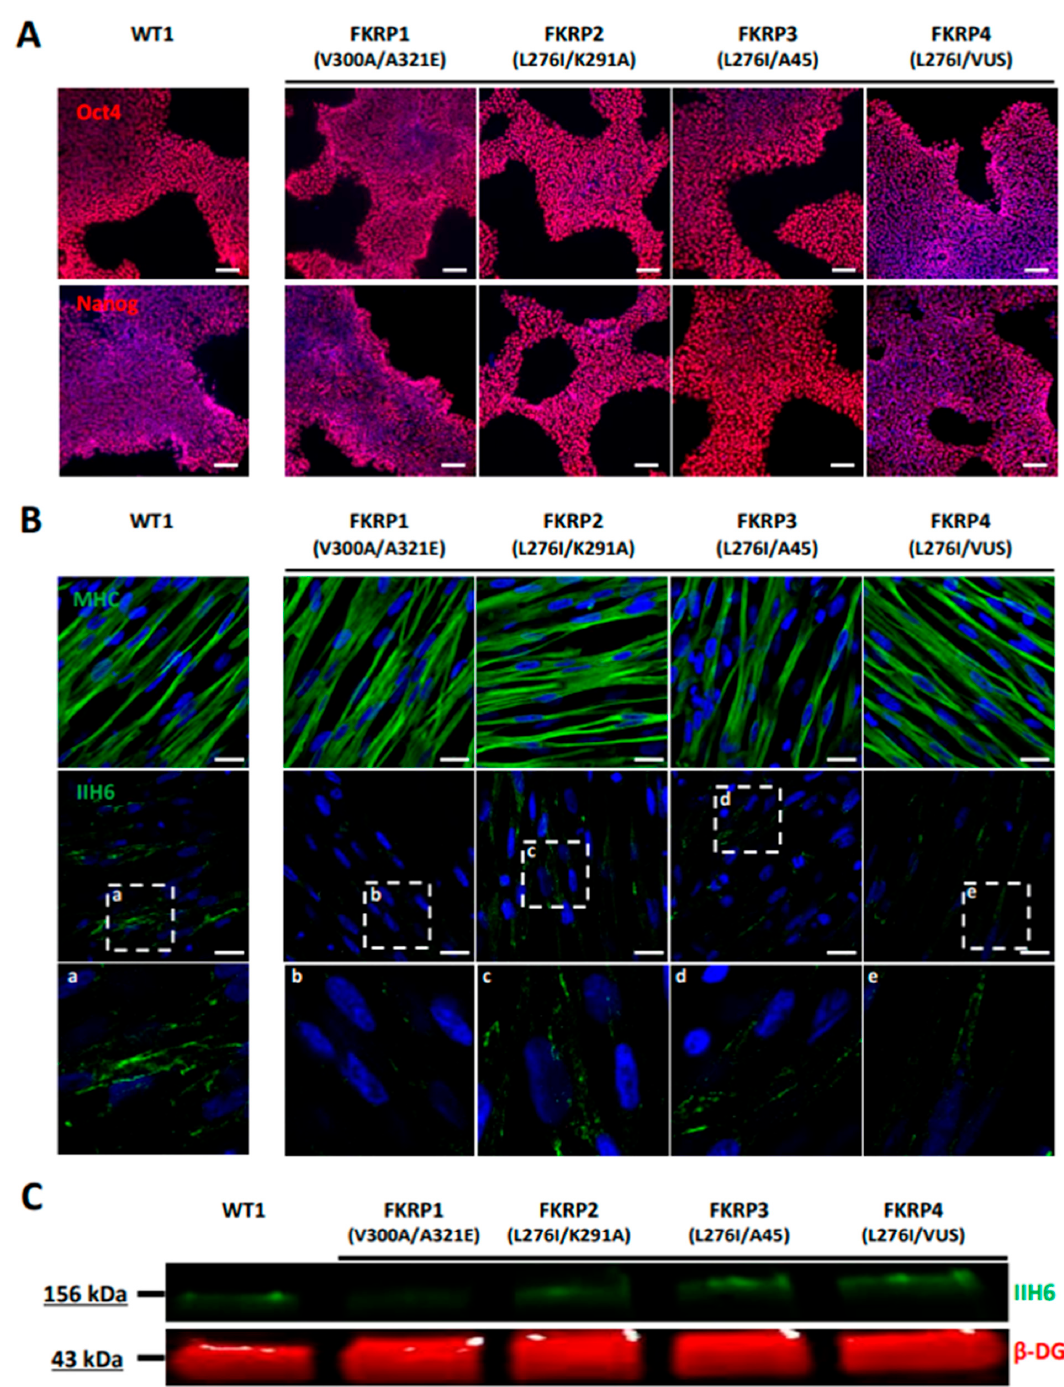
Figure 5. Differentiation and characterization of LGMDR9-affected hiPSC into SkMC. ( A ) Immunos- taining analysis of Oct4 and Nanog in one control and four LGMDR9 hiPSC lines at day 0 of differentiation. ( B ) Immunostaining images of MHC (upper panel) and α -DG glycosylation with IIH6 antibody (middle panel) in one control and four LGMDR9-derived skMt at day 24 of differentiation. White boxes, annotated from “a” to “e”, delineate enlargement of IIH6 staining to visualize higher magnification of α -DG glycosylation in the bottom panel. Nuclei are labeled by Hoechst staining. Scale bar = 20 µ m. ( C ) Immunoblot analysis of α -DG glycosylation in skMt at day 24 of differen- tiation. β -DG was used as the loading control. Abbreviations: MHC, myosin heavy chain; β -DG,